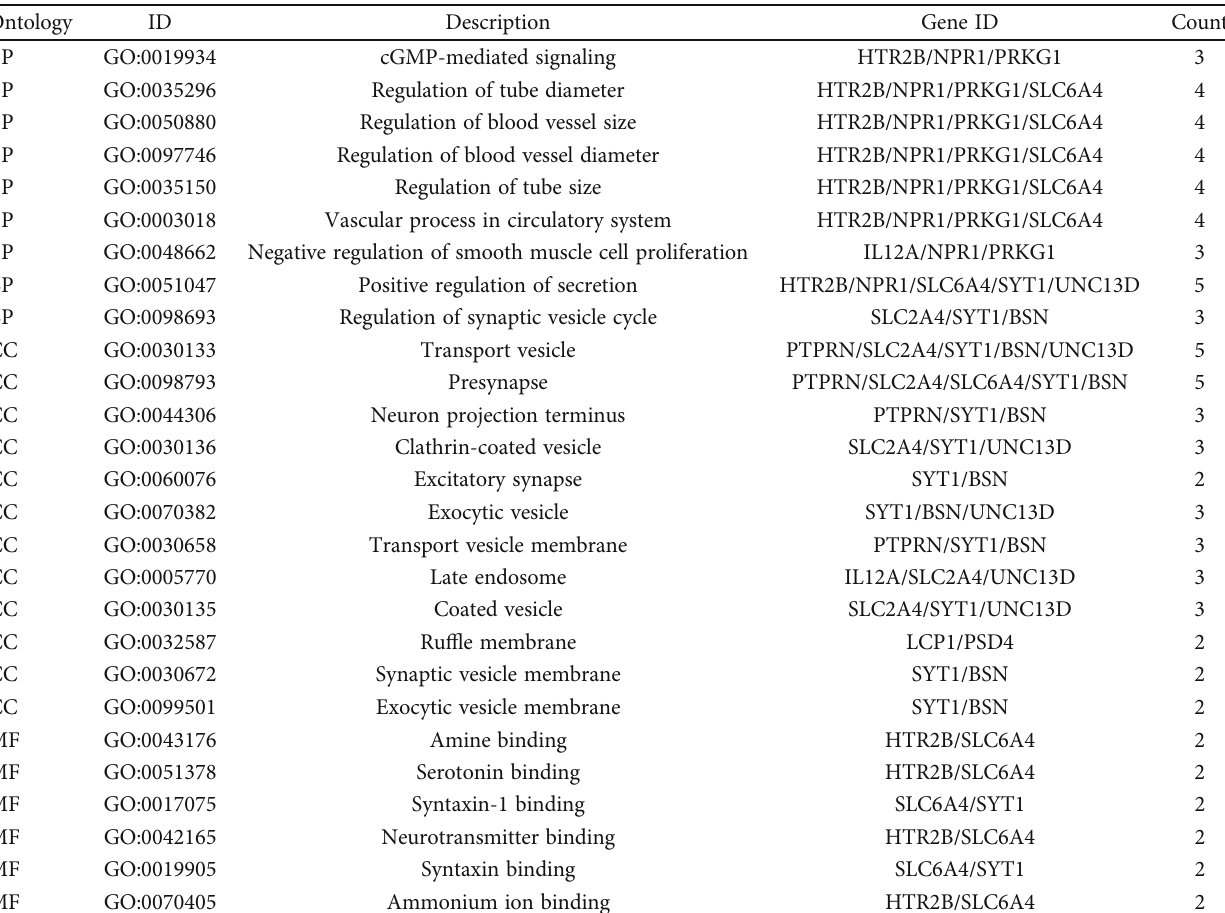
Table 1: GO enrichment